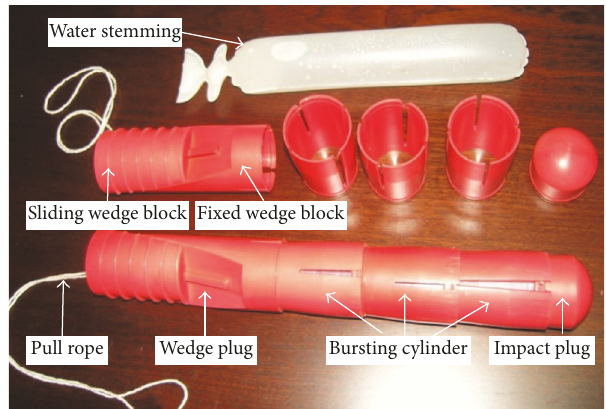
Figure 1: The blast hole plug and its